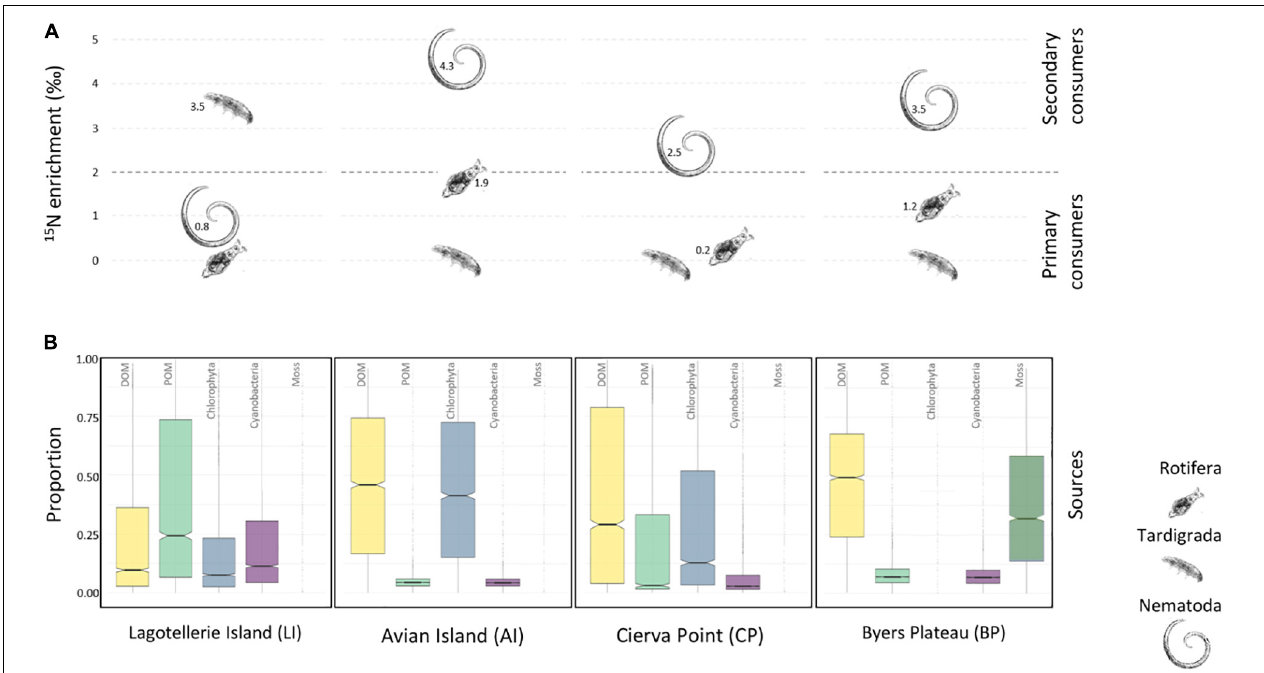
FIGURE 2 | (A) Enrichment in δ 15 N of rotifers, nematodes, and Hypsibiidae tardigrade. For estimating the differences between “primary consumers” and “secondary consumers,” an enrichment of 2–4 was considered. (B) Simmr credibility interval plot of the contribution of potential food sources of the studied microbial mats (boxes enclose the 50% credibility interval; lines within boxes represent median (cid:104)